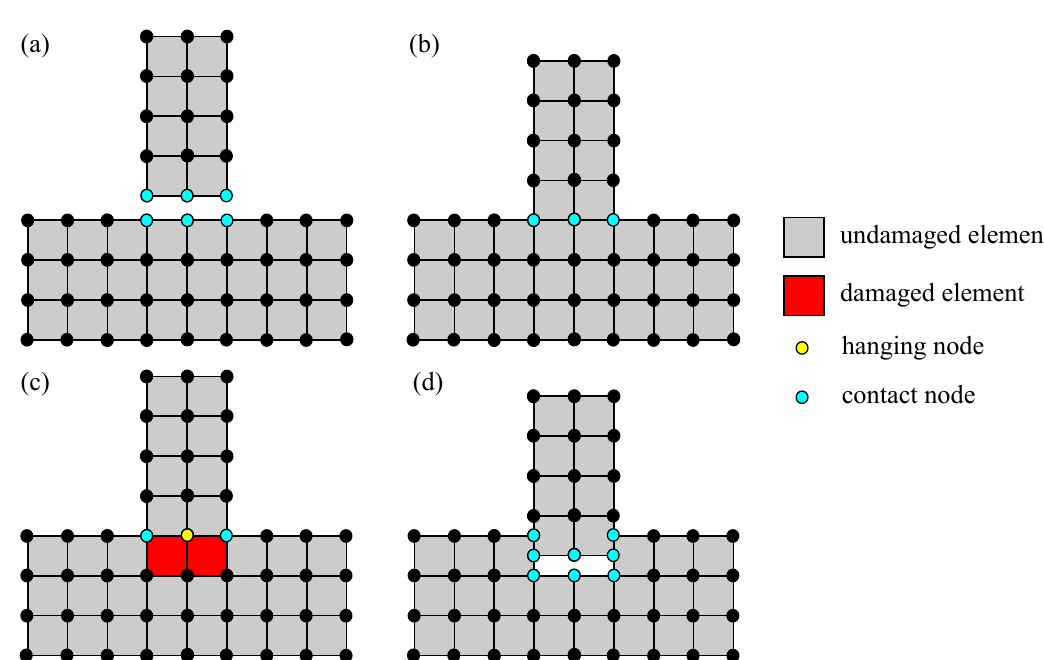
Figure 7. Coupled contact mechanism and adaptive element erosion at impact cases: ( a ) initial condition, ( b ) contact process, ( c ) detection of damaged elements during contact, ( d ) searching of new contact nodes after removing